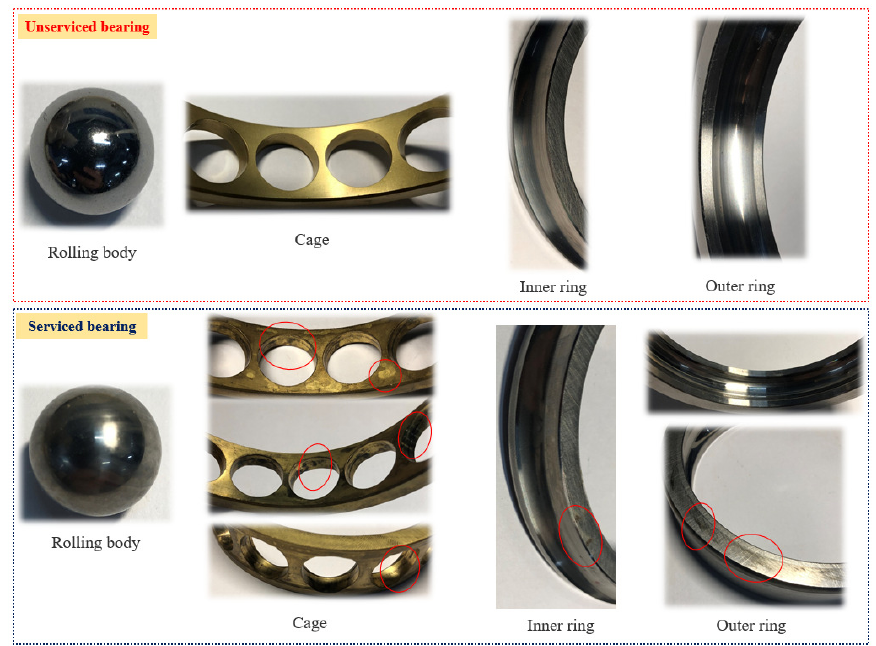
Figure 6. Naked-eye comparison of the surface conditions of high-performance bearings before and after the durability experiments.